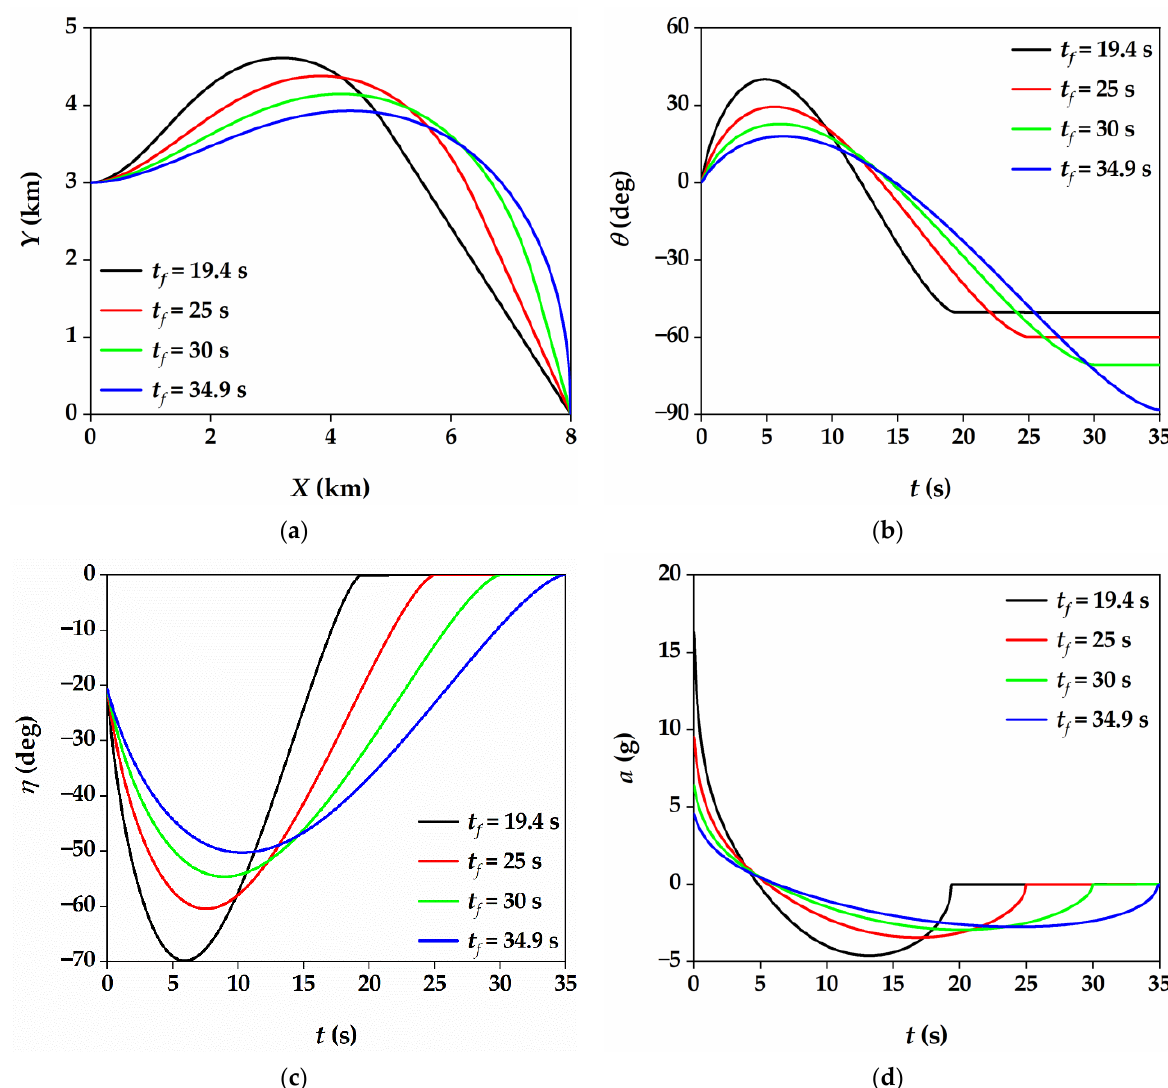
Figure 3. Simulation results of (19) under different values of coefficient t f . ( a ) Missile flight trajectory ; ( b ) Flight path angle ; ( c ) Lead angle ; ( d ) Missile acceleration.